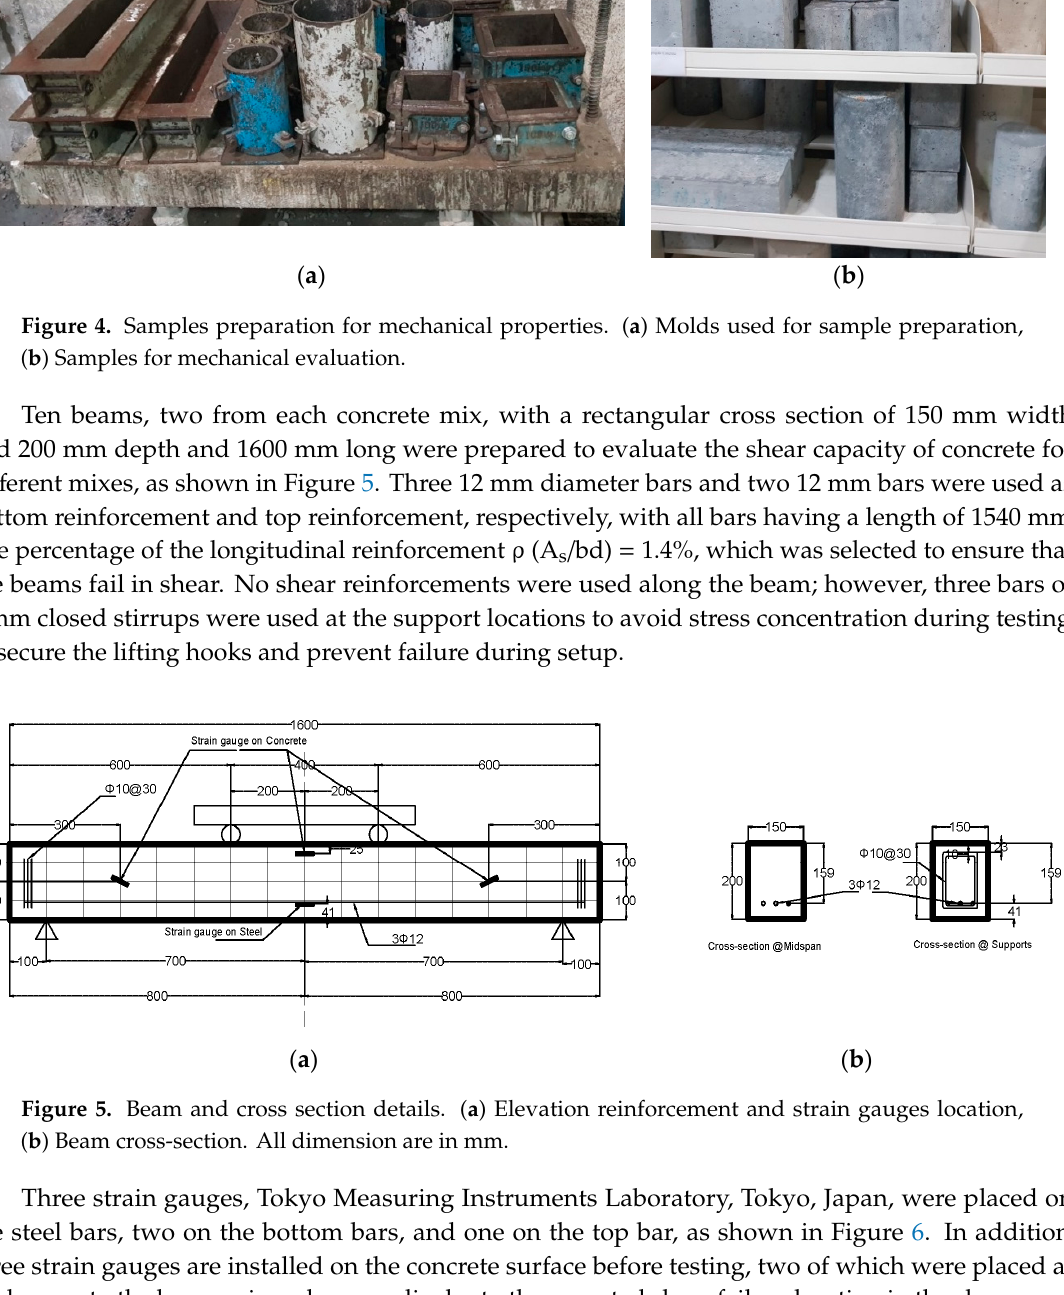
Figure 5. Beam and cross section details. ( a ) Elevation reinforcement and strain gauges location, ( b ) Beam cross-section. All dimension are in mm.